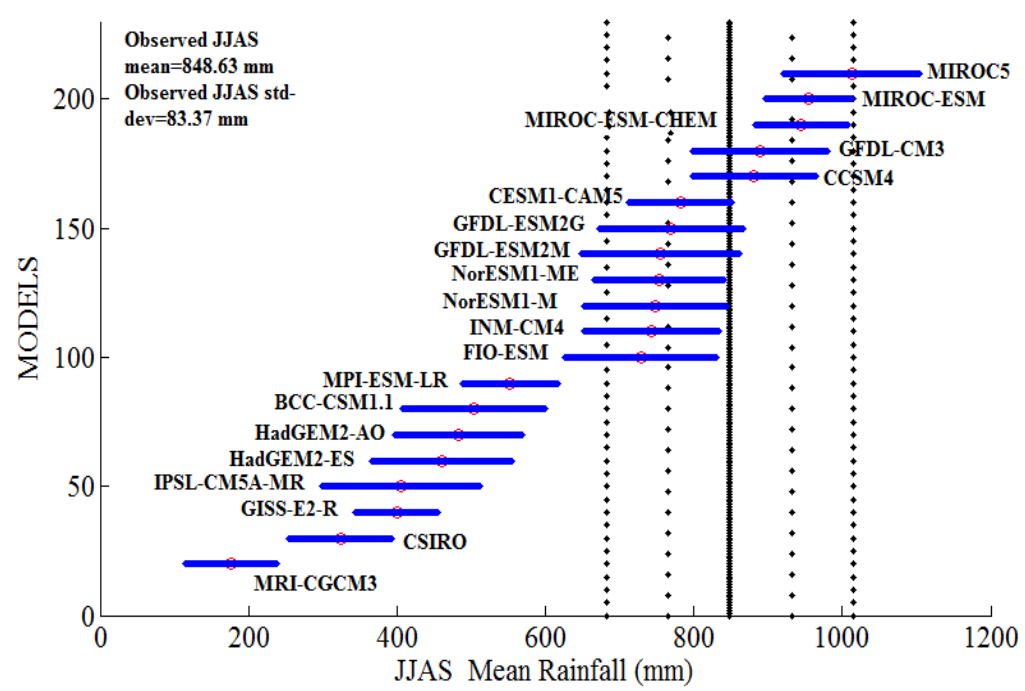
Figure 2. AISMR mean from 20 models for the historic period of 1871–2005. The black vertical line shows the all-India mean monsoon rainfall from observations for the period of 1871–2005, and the dashed lines show the mean plus/minus one, and twice the standard deviation of the all-India mean rain. Circles with error bars represent mean and mean plus/minus one standard deviation for the 20 comprehensive models from 1871 to